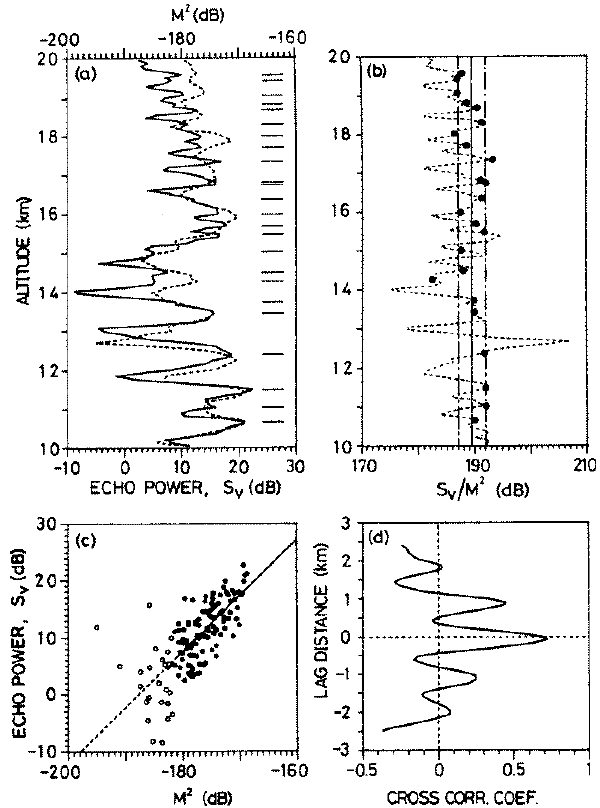
Fig. 10. (a) Comparison between a profile of the square of the verti- cal gradient of potential refractive index M 2 deduced from balloon measurements at a 150-m range resolution (dashed line) with a ver- tical echo power profile (solid line) observed by the MU radar (b) ratio (c) a linear regression curve and (d) cross-correlation function (after Tsuda et al., 1988). The proportionality between the vertical echo power and M 2 (and, in particular, with N 4 for dry atmosphere) seems to be systematic, indicating the VHF ST radars can provide reliable stability